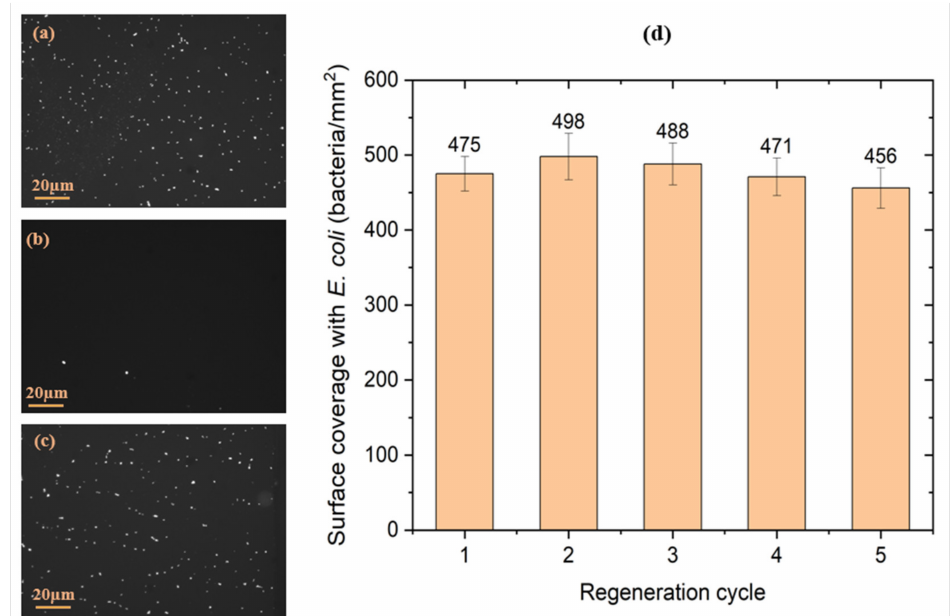
Figure 6. Examples of microscopic images of the antibody-functionalized GaAs biochips following the initial exposure to E. coli suspension ( a ) , after the 1st exposure to the regeneration kit ( b ) and after the 5th exposure to the regenerated kit followed by the exposure to E. coli ( c ). Evolution of the surface coverage with E. coli immunocaptured by the GaAs biochips ( d ) after each regeneration cycle ( n = 3